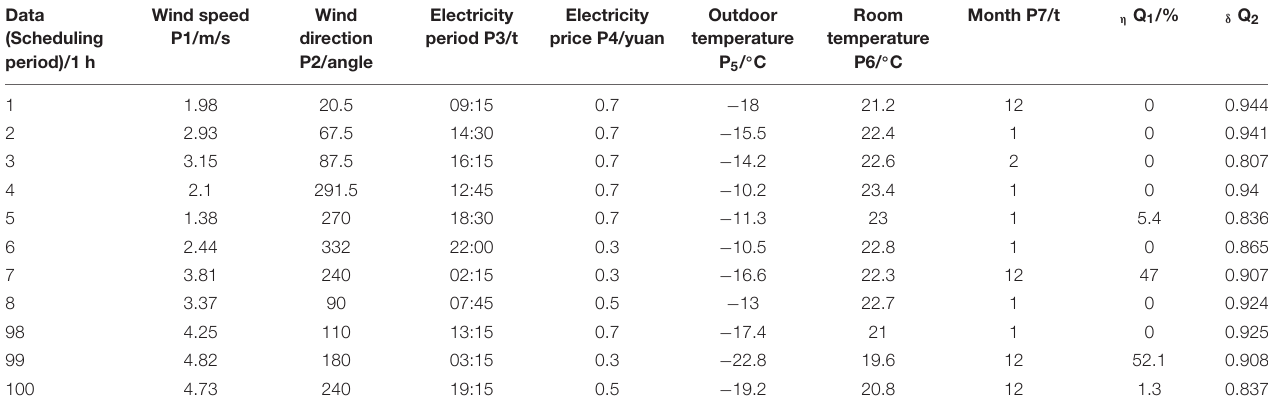
TABLE 3 | Historical data of state